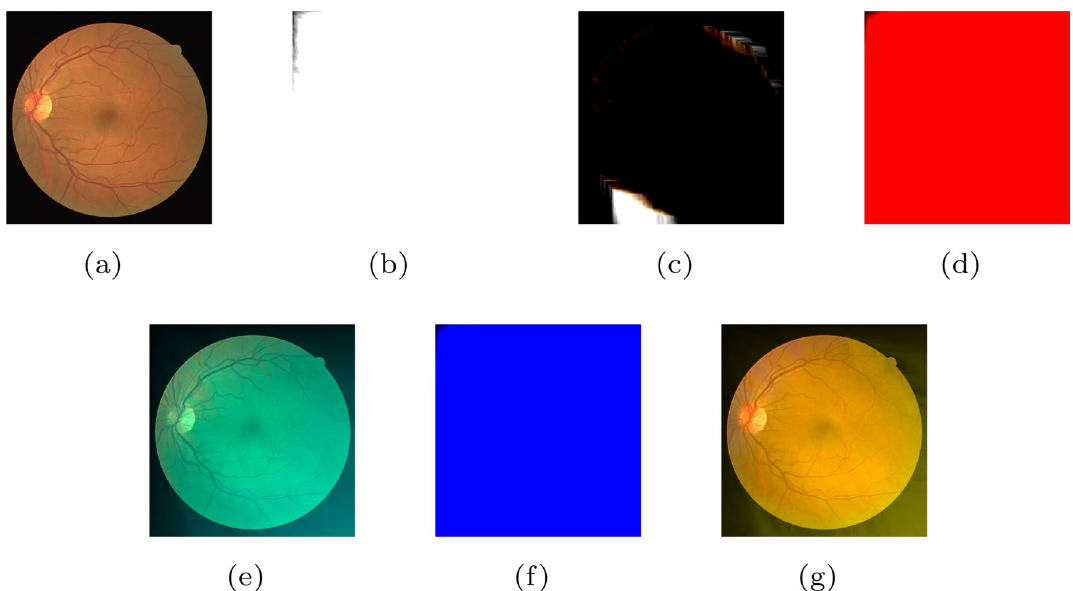
Figure 5. ( a ) The original image without any noise. ( b ) The reconstructed image with noise added to the component Y S . ( c ) The reconstructed image with noise added to the component Y D . ( d ) The reconstructed image with noise added to the components U S . ( e ) The reconstructed image with noise added to the component U D . ( f ) The reconstructed image with noise added to the component V S . ( g ) The reconstructed image with noise added to the component V D